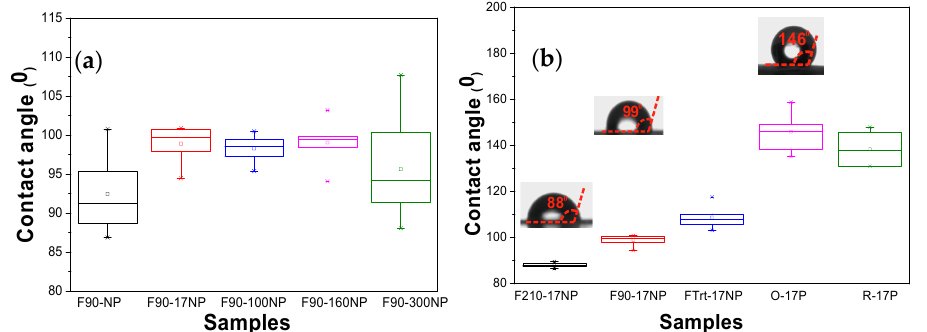
Figure 5. Contact angle of the SiNPs/PVDF nanocomposites: ( a ) PVDF with the SiNPs with different diameters processed at 90 °C and ( b ) SiNPs/PVDF samples with silica nanoparticles (17 nm) with different morphologies.